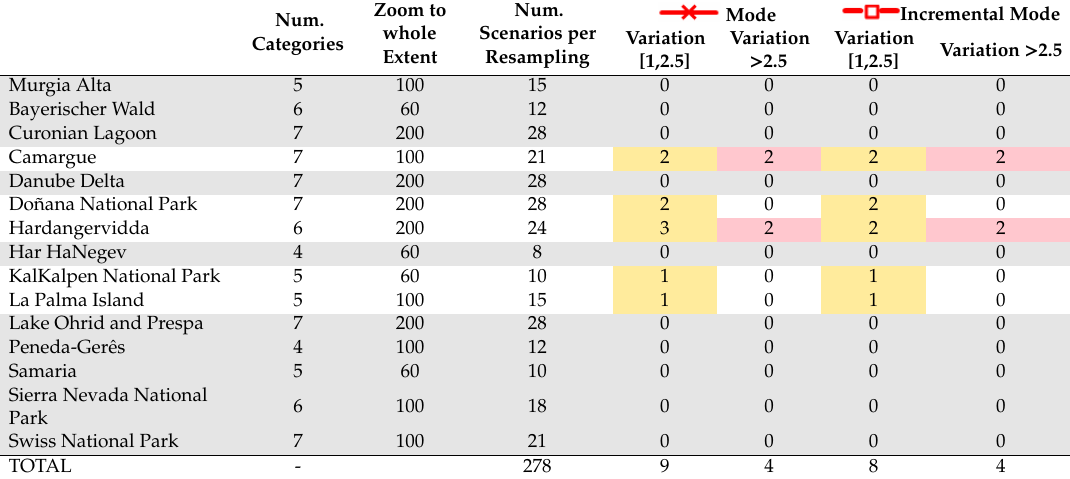
Table 4. Number of scenarios with an absolute maximum variation for each PA for all resolutions and for all categories that have a deviation between 1 and 2.5 percentage points and higher than 2.5 percentage points, taking into account the minimum zoom out needed to see the complete PA. The yellow background highlights scenarios with an absolute variation between 1 and 2.5 percentage points, and the red background highlights scenarios with a variation higher than